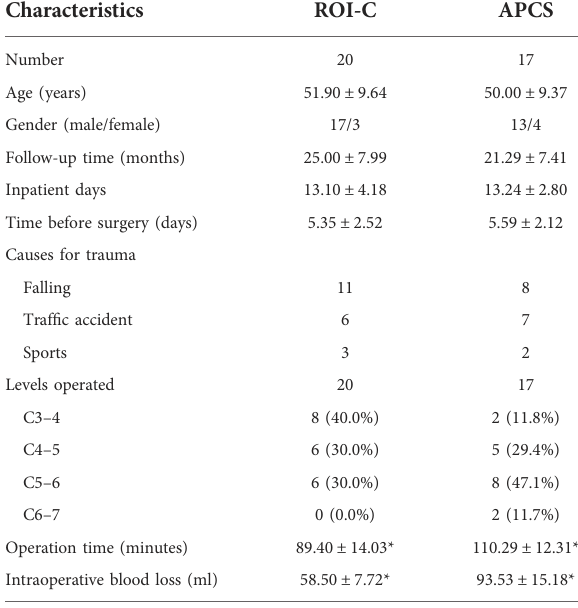
TABLE 1 Characteristics of